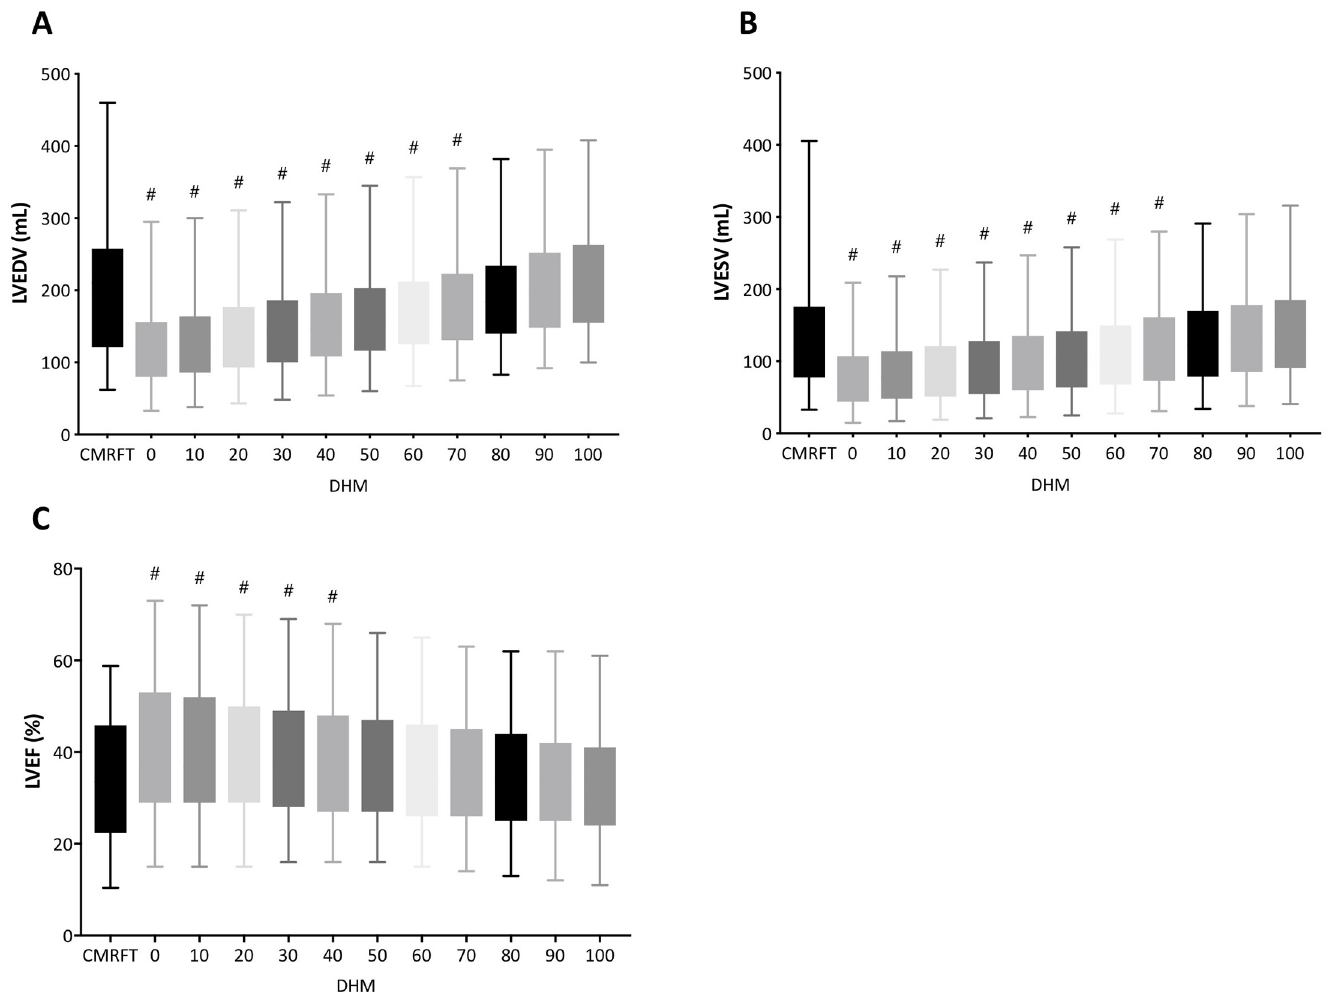
Fig 4. Box and whiskers (minimum to maximum) graphs of left ventricular end-diastolic volume (A), left ventricular end-systolic volume (B), and left ventricular ejection fraction (C) between cardiac magnetic resonance feature tracking and 3D echocardiography with automated quantification software (Dynamic HeartModel) according to change in border